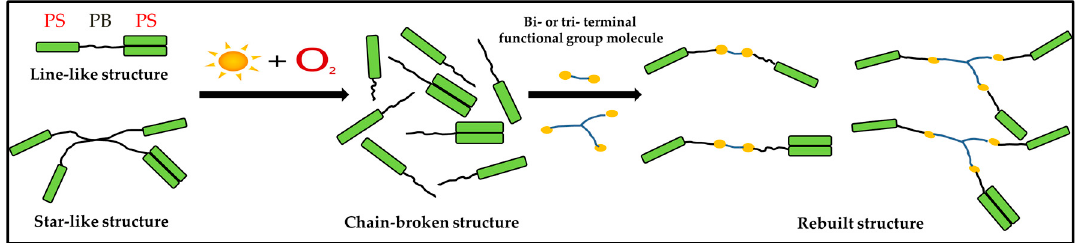
Figure 1. Reaction reconstruction process of poly (styrene-b-butadiene-b-styrene) (SBS).